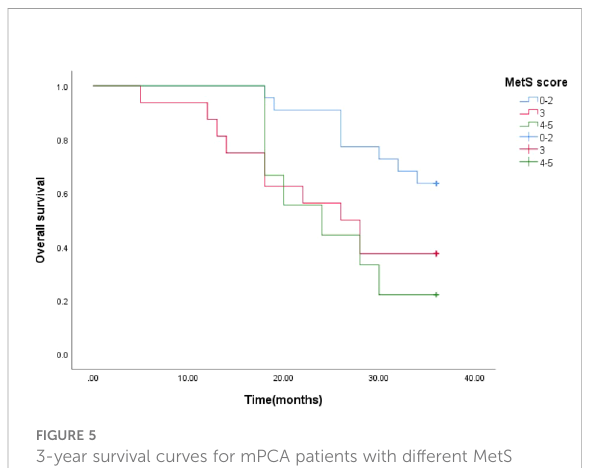
FIGURE 5 3-year survival curves for mPCA patients with different MetS scores.